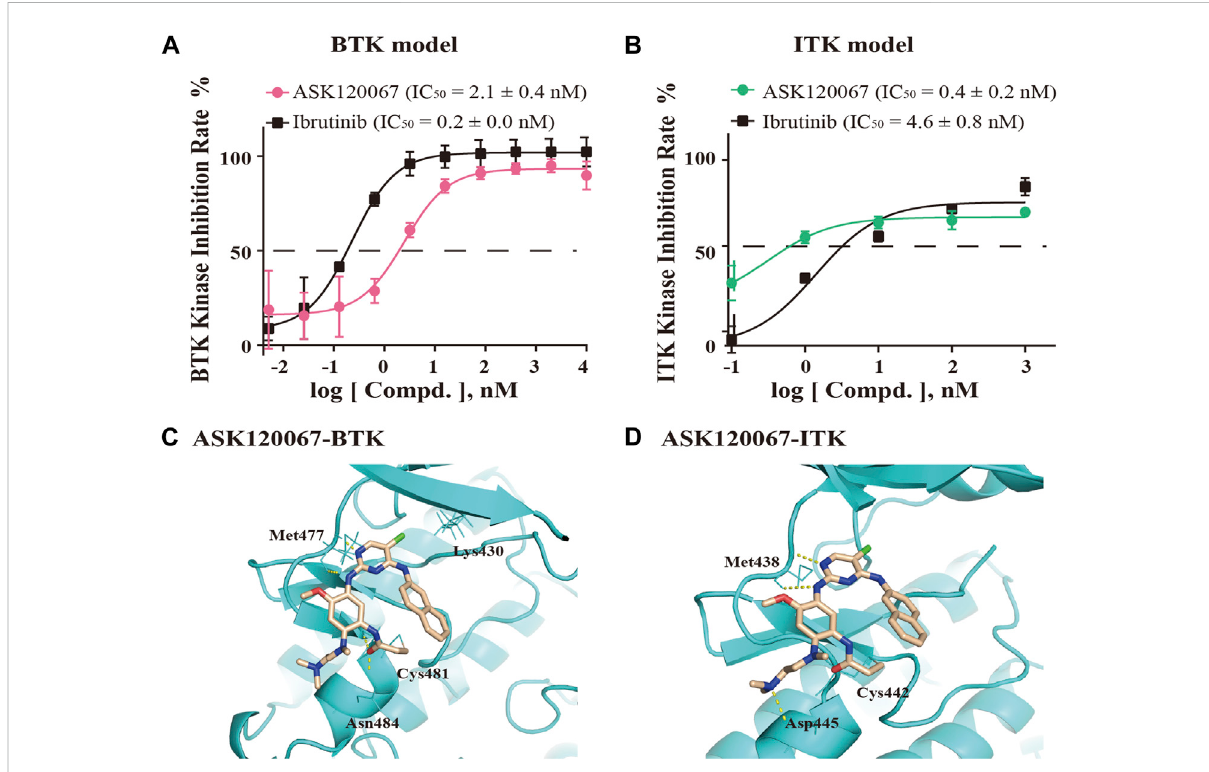
FIGURE 1 ASK120067wasboundcovalentlytoBTK/ITKandinhibitedtheactivityoftheirkinases.Thekinase-inhibitoryactivitiesofASK120067oribrutinib against BTK (A) and ITK (B) were measured using ELISAs. Data are the mean ± SD and experiments were repeated thrice independently. (C) The binding conformation of ASK120067 to the kinase domain of human BTK. ASK120067 formed two hydrogen bonds to the residue Met477, and a covalentbondtotheconservedresidueCys481intheATP-bindingpocket. (D) MolecularmodelingofthebindingmodeofASK120067withthe kinase of ITK. ASK120067 formed two hydrogen bonds to the residue Met438 and a covalent bond to the conserved residue